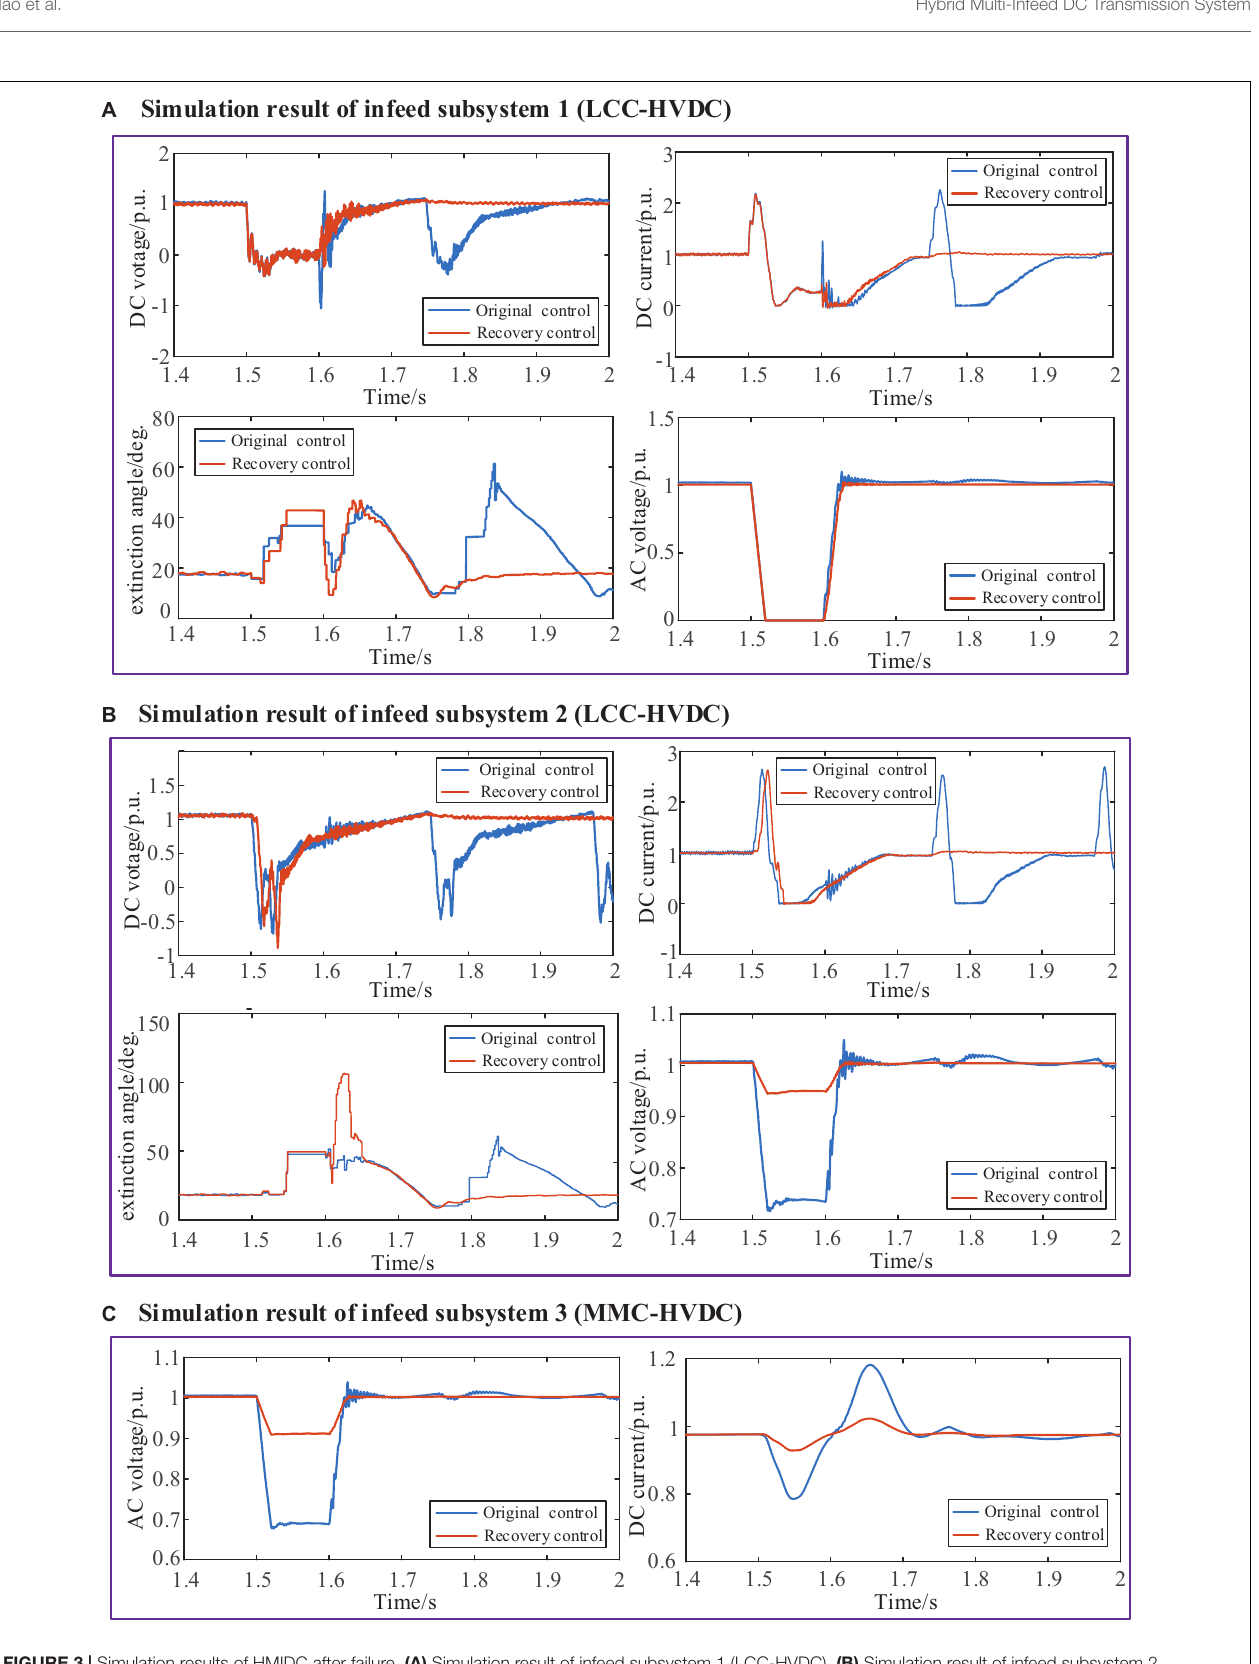
Frontiers in Energy Research |